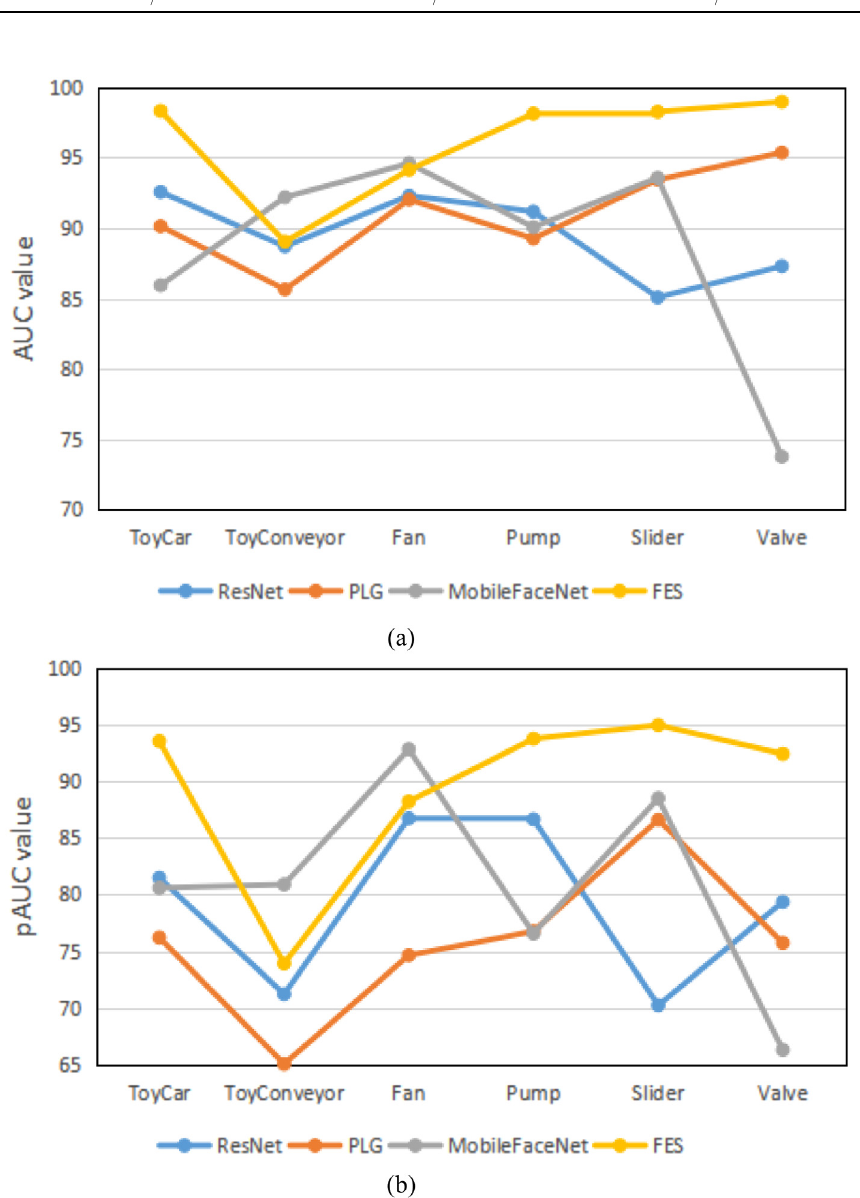
Fig. 10. Comparison line chart of each model: (a) line chart of AUC value; (b) line chart of pAUC